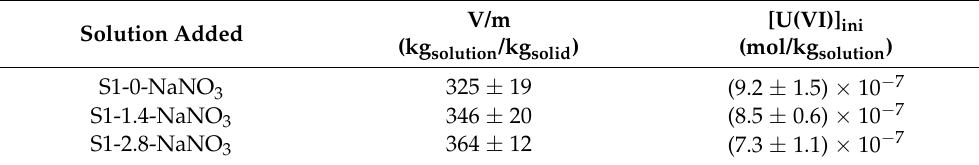
Table 1. Initial conditions for U(VI) batch sorption as a function of NaNO 3 content.